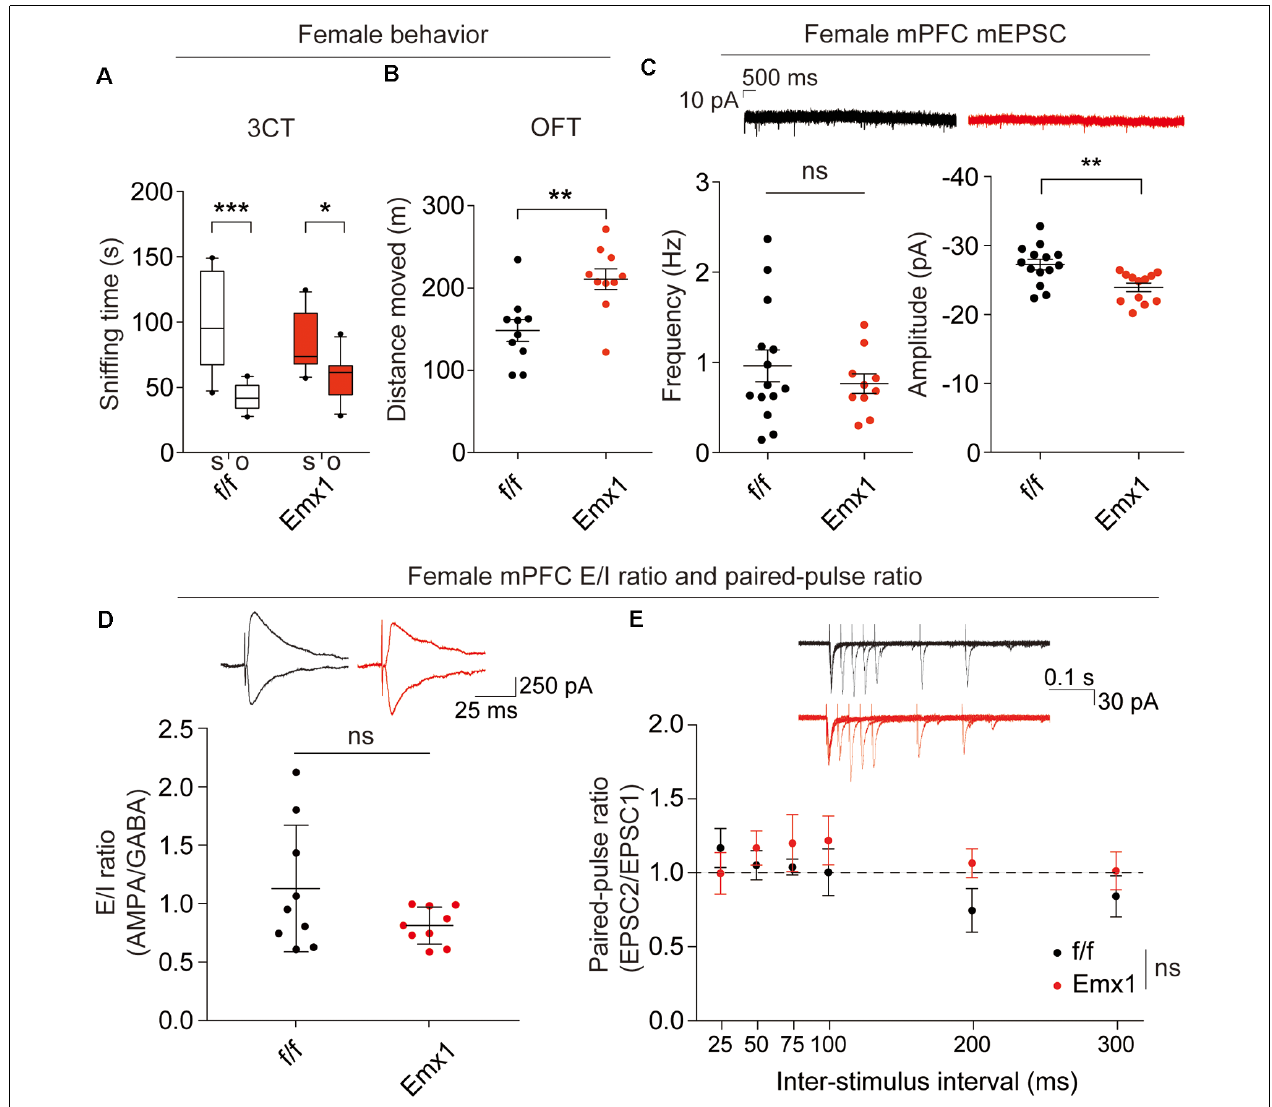
FIGURE 4 | Female Emx1-Cre;Irsp53 fl / fl mice show distinct changes in synaptic transmission and behaviors. (A) Normal social interaction in female Emx1-Cre;Irsp53 fl / fl mice in the three-chamber test (2 months; females). n = 10 mice ( Irsp53 fl / fl or f/f), 10 mice (Emx1-cKO), * P < 0.05, *** P < 0.001, two-way ANOVA with Bonferroni’s test, interaction F (1,36) = 4.035, chamber F (1,36) = 31.58, genotype F (1,36) = 0.0003937. (B) Hyperactivity in female Emx1-Cre;Irsp53 fl / fl mice in the OFT (2 months; females). n = 10 mice ( Irsp53 fl / fl or f/f), 10 mice (Emx1-cKO), ** P < 0.01, Student’s t -test, t = 3.434, df = 18. (C) Decreased amplitude but normal frequency of mEPSCs in layer V pyramidal neurons in the prelimbic region of the mPFC in Emx1-Cre;Irsp53 fl / fl (3 months; females). n = 14 neurons from three mice for f/f-mEPSC, 10, 3 for Emx1-mEPSC in mPFC, ** P < 0.01; ns, not significant, Mann–Whitney test for frequency, Student’s t -test for amplitude. mEPSC frequency, Mann-U 62; mEPSC amplitude, t = 3.278, df = 24. (D) Normal ratio of evoked EPSCs and IPSCs in layer V pyramidal neurons in the prelimbic region of the mPFC in female Emx1-Cre;Irsp53 fl / fl mice (2–3 months; females). n = 9 neurons for three mice for f/f, 9, 3 for Emx1, ns, not significant, Student’s t -test, t = 1.675, df = 16. (E) Normal paired-pulse ratio in layer V pyramidal neurons in the prelimbic region of the mPFC in female Emx1-Cre;Irsp53 fl / fl (2–3 months; females). n = 6 neurons for three mice for f/f, 6, 3 for Emx1, ns, not significant, two-way ANOVA with Bonferroni’s test, interaction F (5,90) = 0.8666, time F (5,90) = 0.9748, genotype F (1,18) =